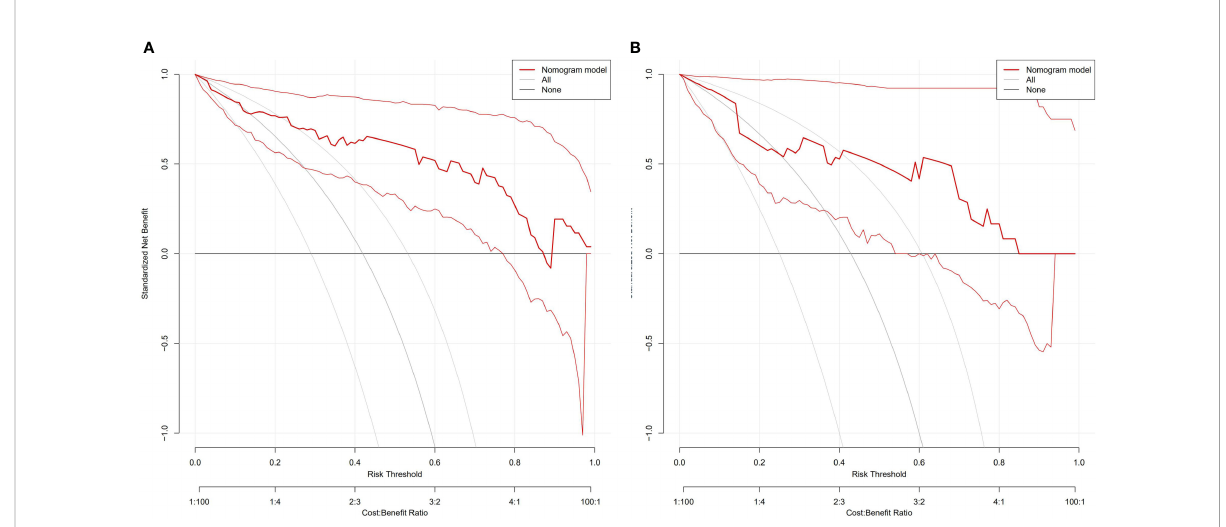
FIGURE 6 DCA of the nomogram to evaluate the clinical practicability in training (A) and validation cohorts (B) . The vertical axis displays standardized net bene fi t. The two horizontal axes show the correspondence between risk threshold and cost: bene fi t ratio. The combined nomogram achieves more net bene fi t across the majority of the range of threshold probabilities compared with the treat-all strategy (gray line), and treat-none strategy (horizontal black